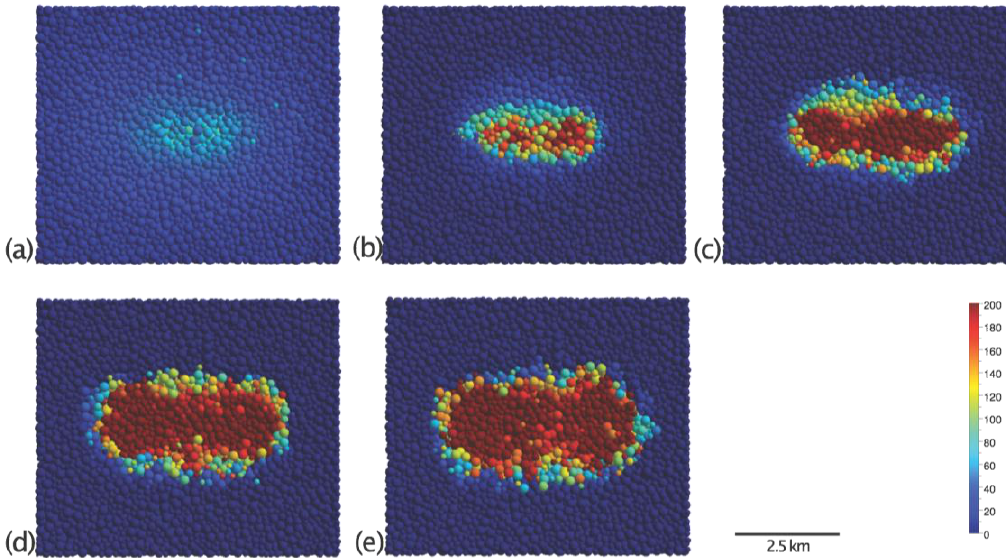
Figure 8. Evolution of (incremental) caldera surface subsidence accrued during the preceding 200 m of basal subsidence at ( a ) 200, ( b ) 400, ( c ) 600, ( d ) 800, and ( e ) 1000 m basal subsidence for an experiment with a piston with a flat, rectangular roof.